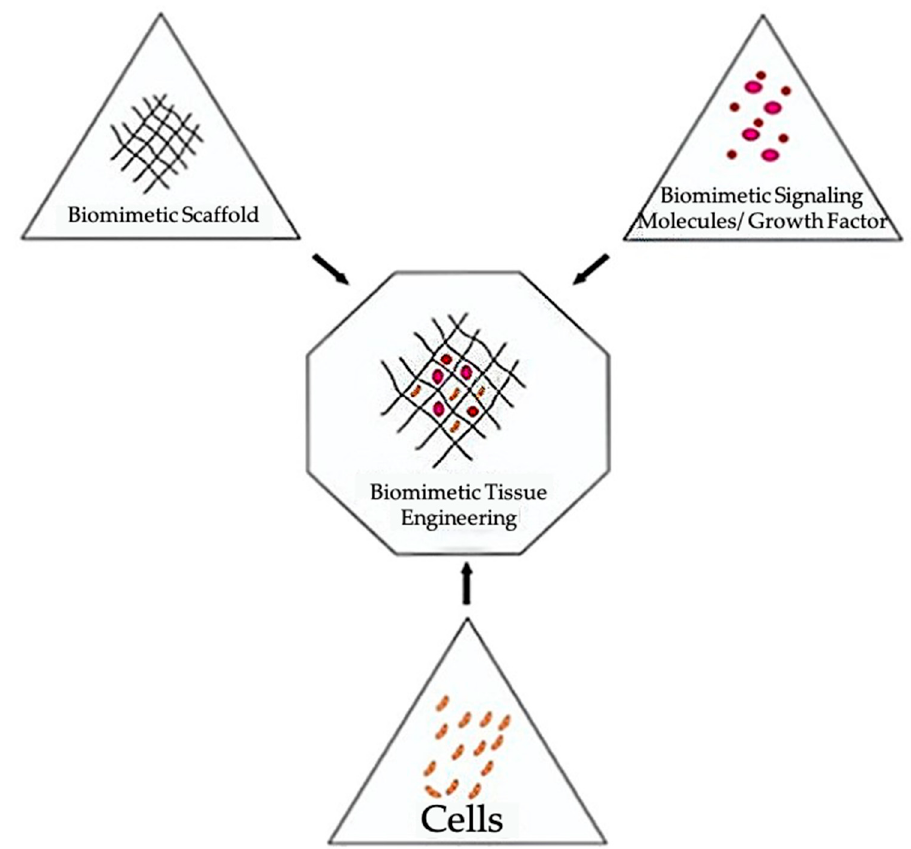
Figure 2. The main components used when constructing biomimetic tissues [32]. This figure is being reprinted under a Creative Commons BY 4.0 license.